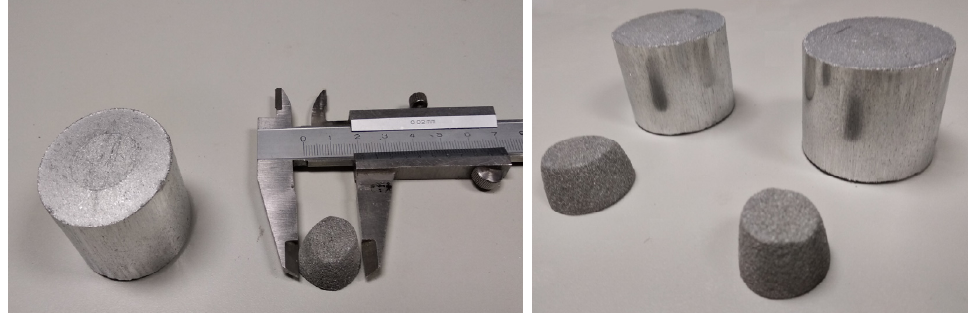
16.1 Table 3. Dimensions of the aluminum test piece and the residue from the second test.